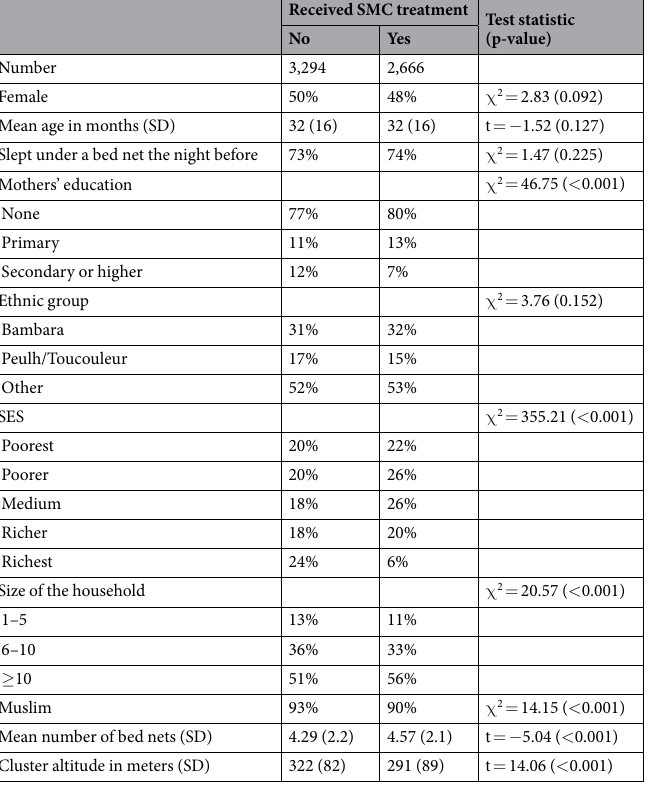
Table 1. Population characteristics. SD standard deviation; SES socio-economic status; SMC seasonal malaria